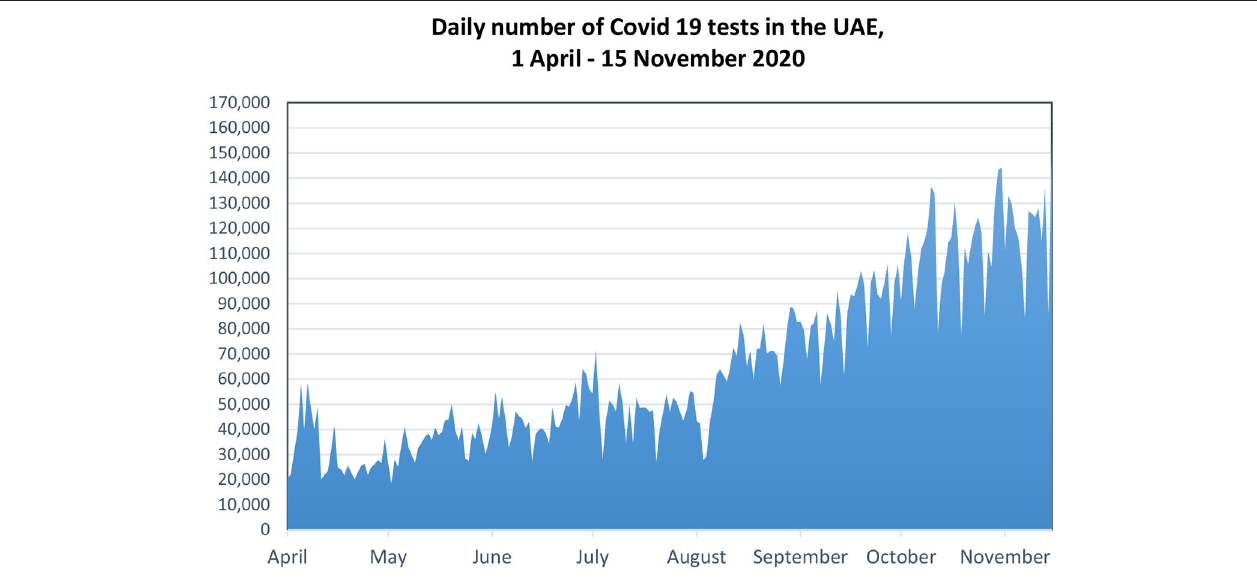
FIGURE 1 | Daily number of COVID-19 tests in the UAE. Source: UAE Federal Competitiveness and Statistics Authority